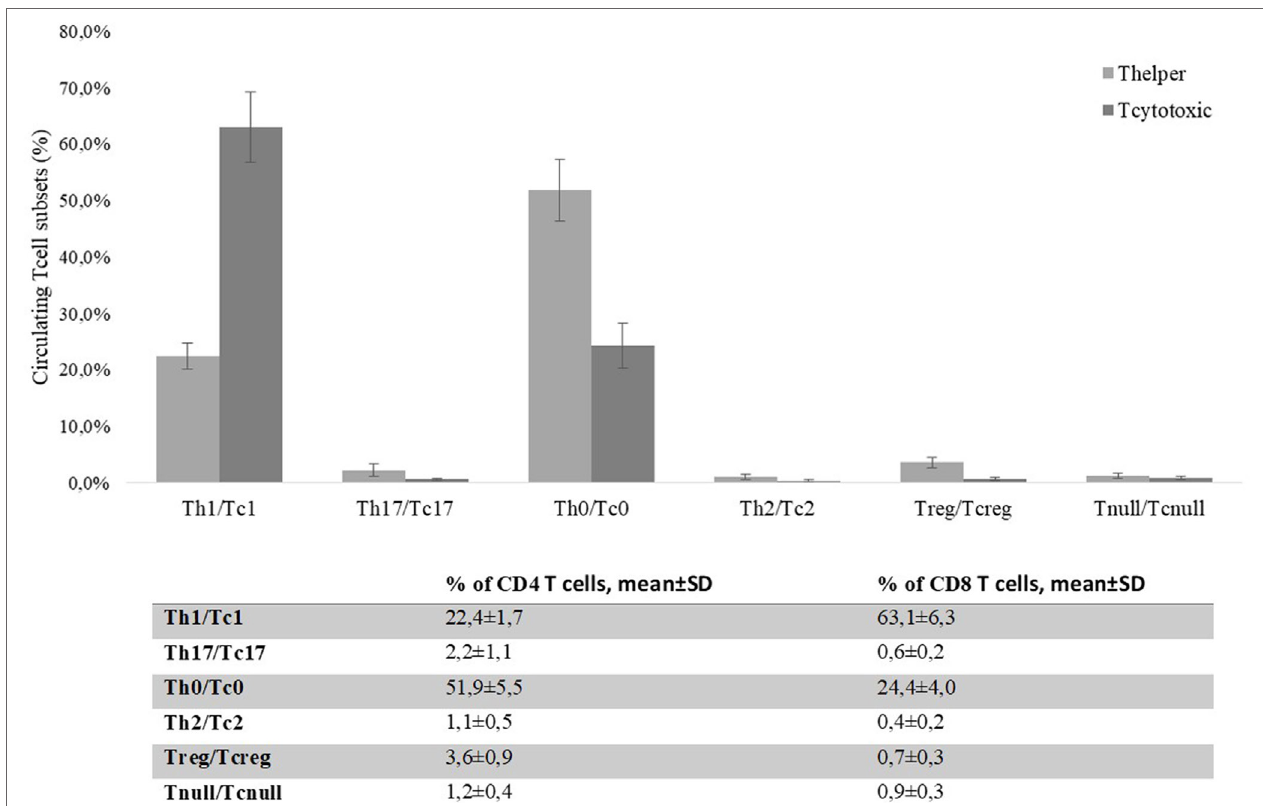
FigUre 7 | Percentages of CD4 + and CD8 + circulating T cells’ subsets present in colorectal cancer patients’ blood on the day of the surgery ( T = 0). Evaluation of the T cell subsets was performed by flow cytometry basing on specific markers’ expression. T helper and T cytotoxic subsets are reported as percentages (mean ± SD) of total CD4 + or CD8 + T cells,